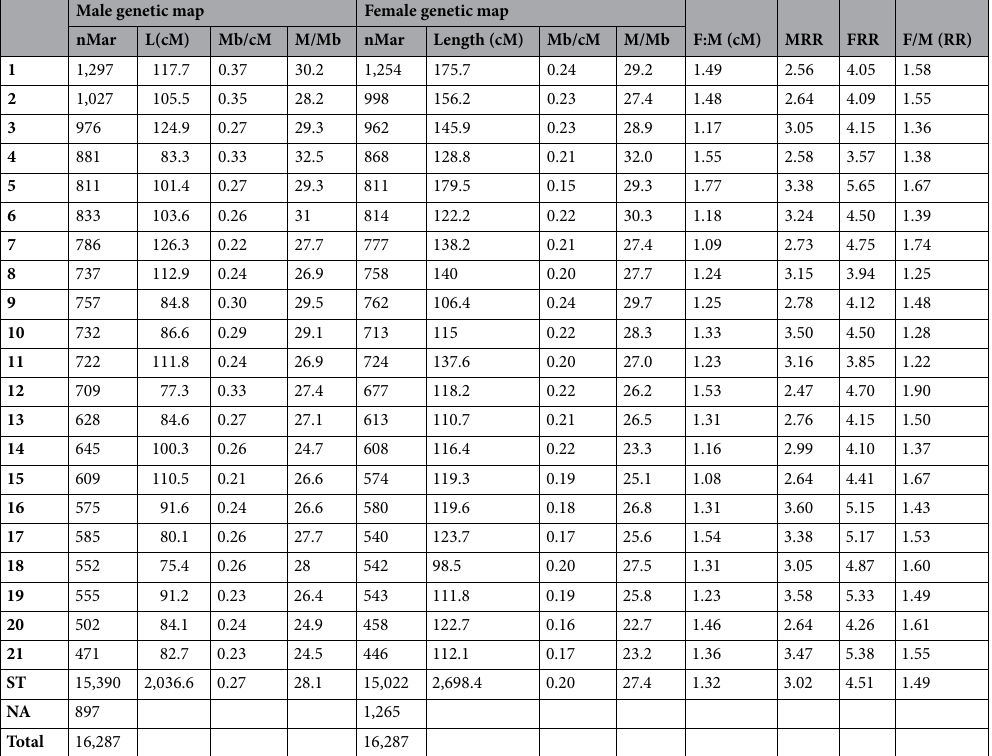
Table 5. Refined genetic maps for male (M) and female (F). The genetic (cM) length of each linkage group, number of markers (nMar), the ratio physical to genetic length (Mb/cM), marker density (markers per megabase; M/Mb), the F:M ratio of genetic map length, the recombination rates (RR) in both sexes and the F:M ratio of RR are